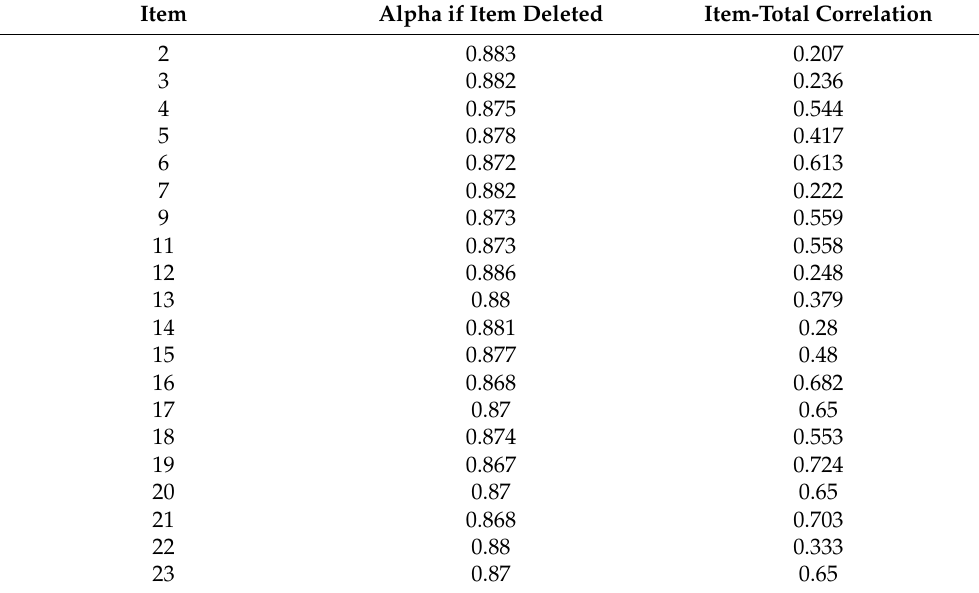
Table 6. Results of the tool reliability